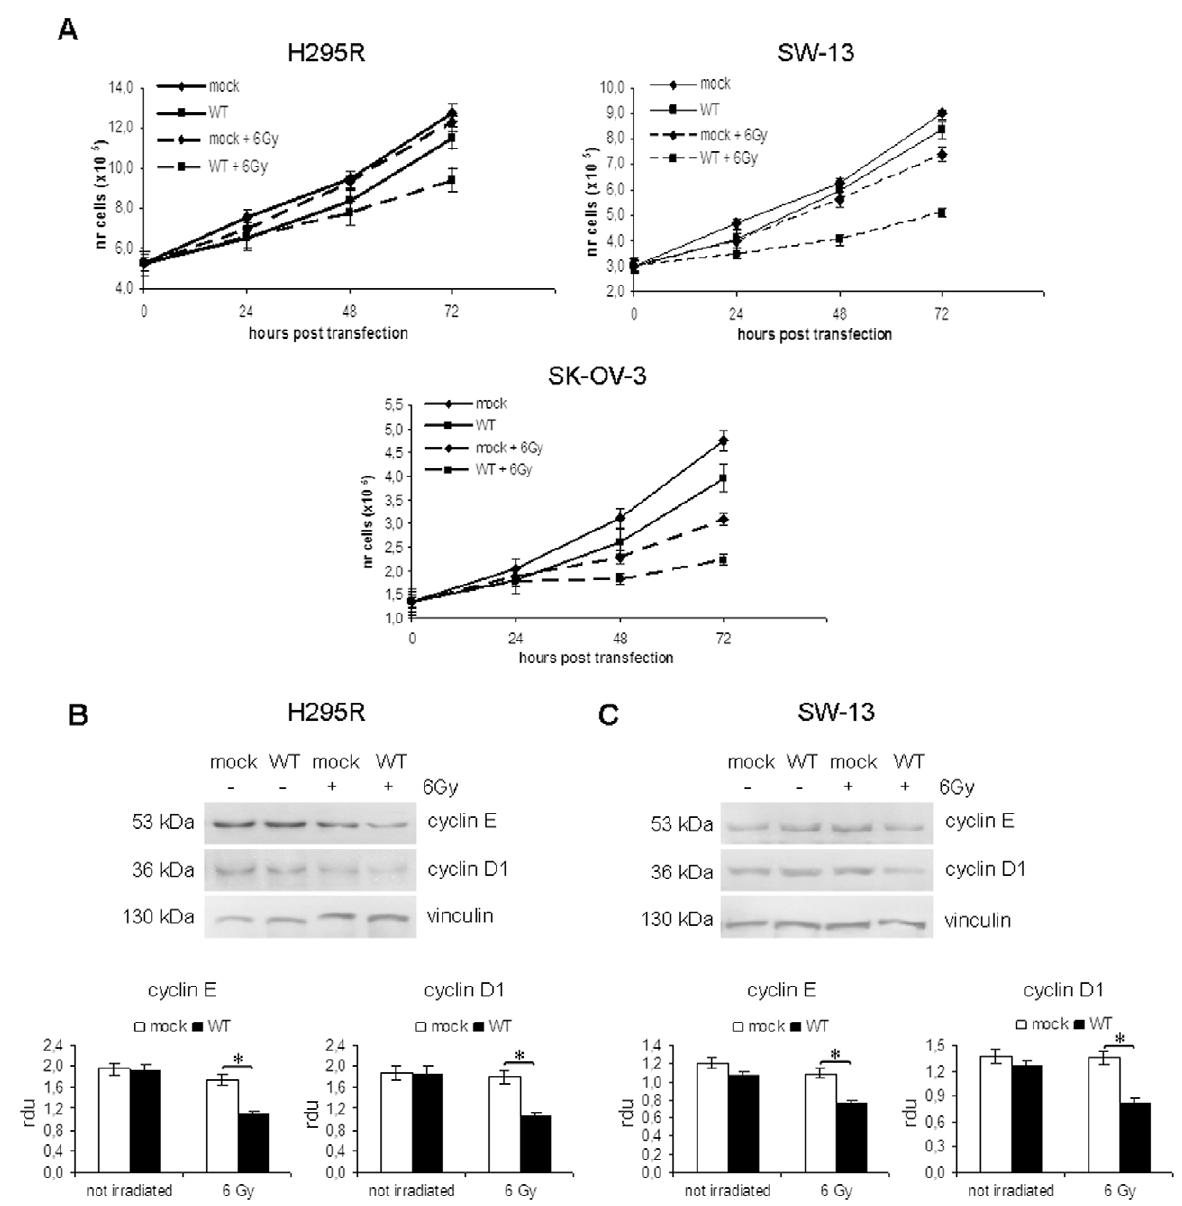
Figure 2. Effect of p53 over-expression and irradiation on cell proliferation in H295R, SW-13 and SK-OV-3 cells. Cell growth was evaluated in H295R, SW-13 and SK-OV-3 cell lines transfected with empty vector (mock) or p53-vector (WT), either irradiated or not. (A) In H295R cell lines (left), ionizing radiation (IR) treatment induces a significant inhibition of cell growth in cells expressing wild type p53, starting from 48 h after transfection ( 2 18% compared to mock irradiated cells; p , 0.05) and reaching 2 25% after 72 h (p , 0.01). Irradiation does not induce a stable effect in SW-13 cells (right) transfected with empty vector, whereas cells expressing wild type p53 are significantly inhibited at 48 h after transfection ( 2 28%; p , 0.05) until the end of the experiment ( 2 31%; p , 0.01). In SK-OV-3 cells (bottom), p53 restoration induces an strong effect on cell growth, which is evident since 48 from transfection ( 2 20% of growth inhibition in WT + IR sample compared with mock + IR; p , 0.01) and endures up to 72 h ( 2 28%; p , 0.01). Data are mean 6 S.D. of at least three independent experiments carried out by duplicates. (B) Western blotting analysis of cyclin E and cyclin D1 expression in H295R cells at 72 h after transfection revealed a down-regulation of these proteins in cells expressing wt p53 treated with IR at a dose of 6 Gy. (C) Analysis of cyclin E and cyclin D1 expression in SW-13 cell line by Western blotting shows a decrease in protein levels in samples transfected with p53-vector after irradiation. Bands’ intensities were quantified with ImageJ software, using vinculin for normalization. (*, p , 0.05).